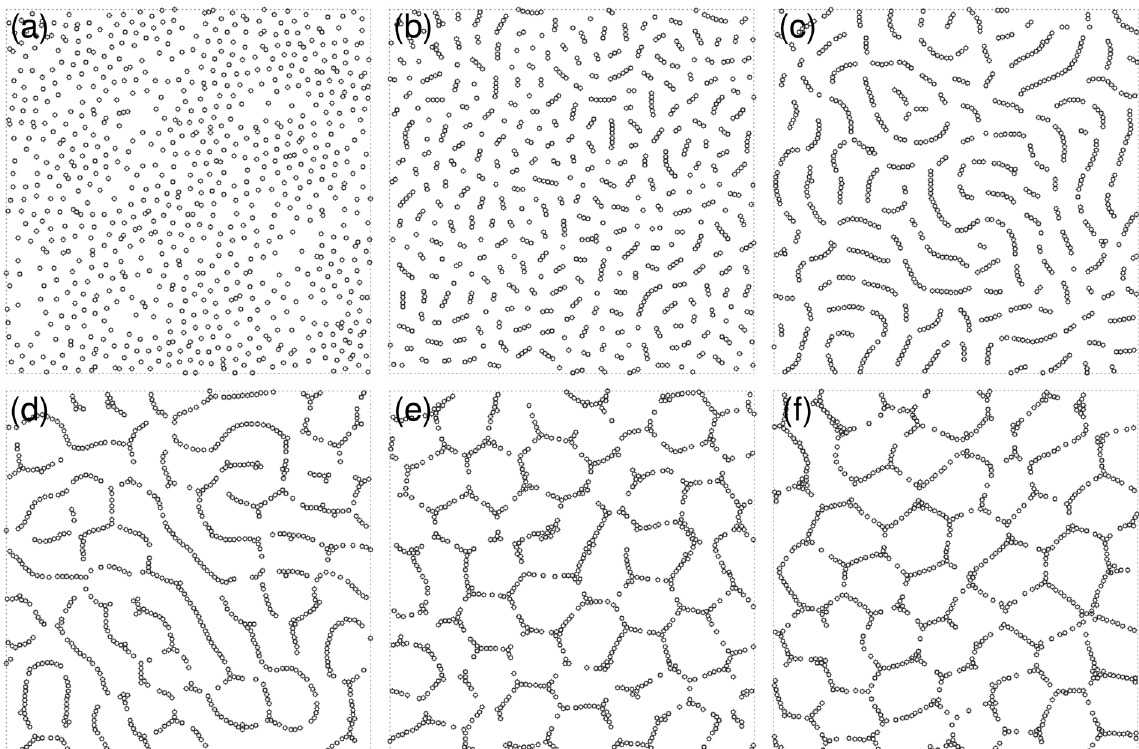
Figure 2. Steady-state configurations of a cognitive-agent system. Snapshots of a two-dimensional system with filling fraction φ = 0.1 ( N = 800, L = 80 σ ) in steady-state configurations. As the size of the cognitive map λ increases, complex structures emerge. ( a ) At λ = 0.8 σ the agents are randomly distributed. ( b ) At λ = 3.2 σ agents start forming short linear chains. ( c ) At λ = 5.6 σ the chains outline a labyrinthine pattern. ( d ) At λ = 7.6 σ the labyrinthine pattern continuously changes into a cellular structure. At λ = 10 σ ( e ) and λ = 10.8 σ ( f ) the cellular structure is well formed. Thus, cognitive agents capable of ‘intelligent’ response to their environment and maximizing their cognitive map information exhibit a clear phase transition from disorder (at small λ ) to order (at large λ